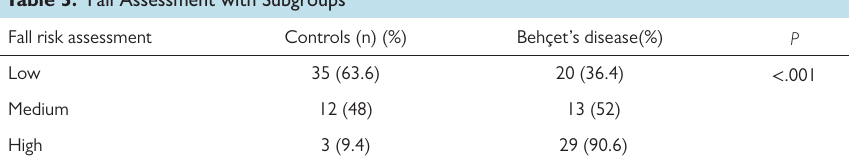
Table 5. Fall Assessment with